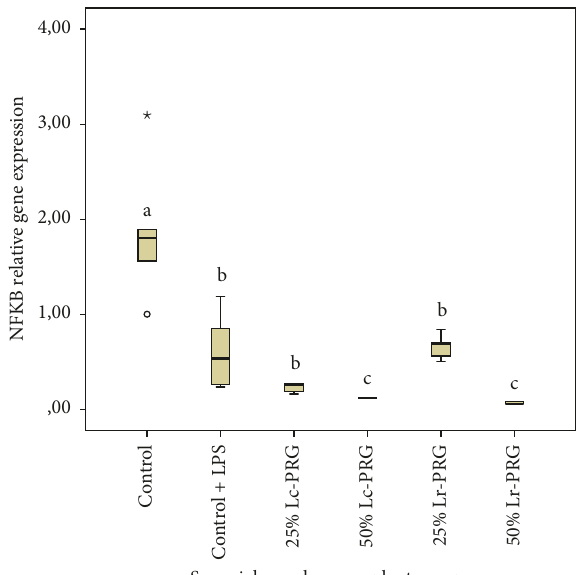
Figure 3: Box plot of median relative matrix metalloproteinase 13 (MMP-13) gene expression. a–d Lowercase letters denote significant differences (𝑝 > 0.05) between synovial SME groups treated with Lc-PRG and Lr-PRG supernatants at different concentrations (25 and50%).Groupswiththesamelowercaseletterarenotsignificantly different. ⋆ denotes extreme value, showing nonparametric